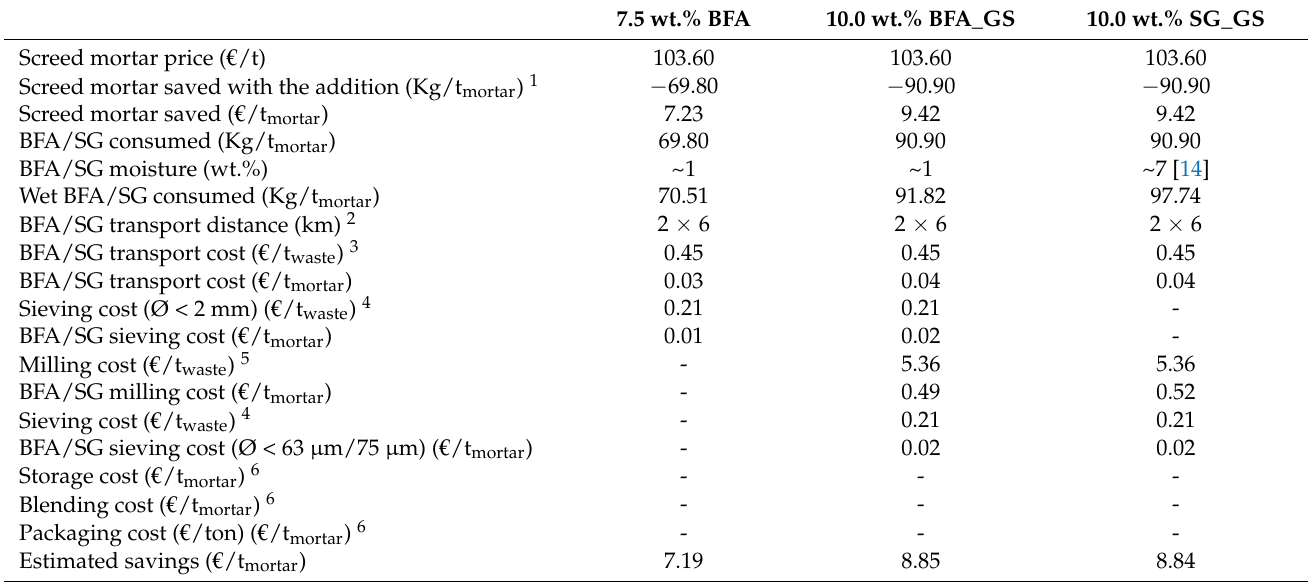
Table 5. Costs and estimated savings resulting from the proposed valorization procedure. In this scenario, the paper-pulp producer is only 6 km away from the mortar producer.